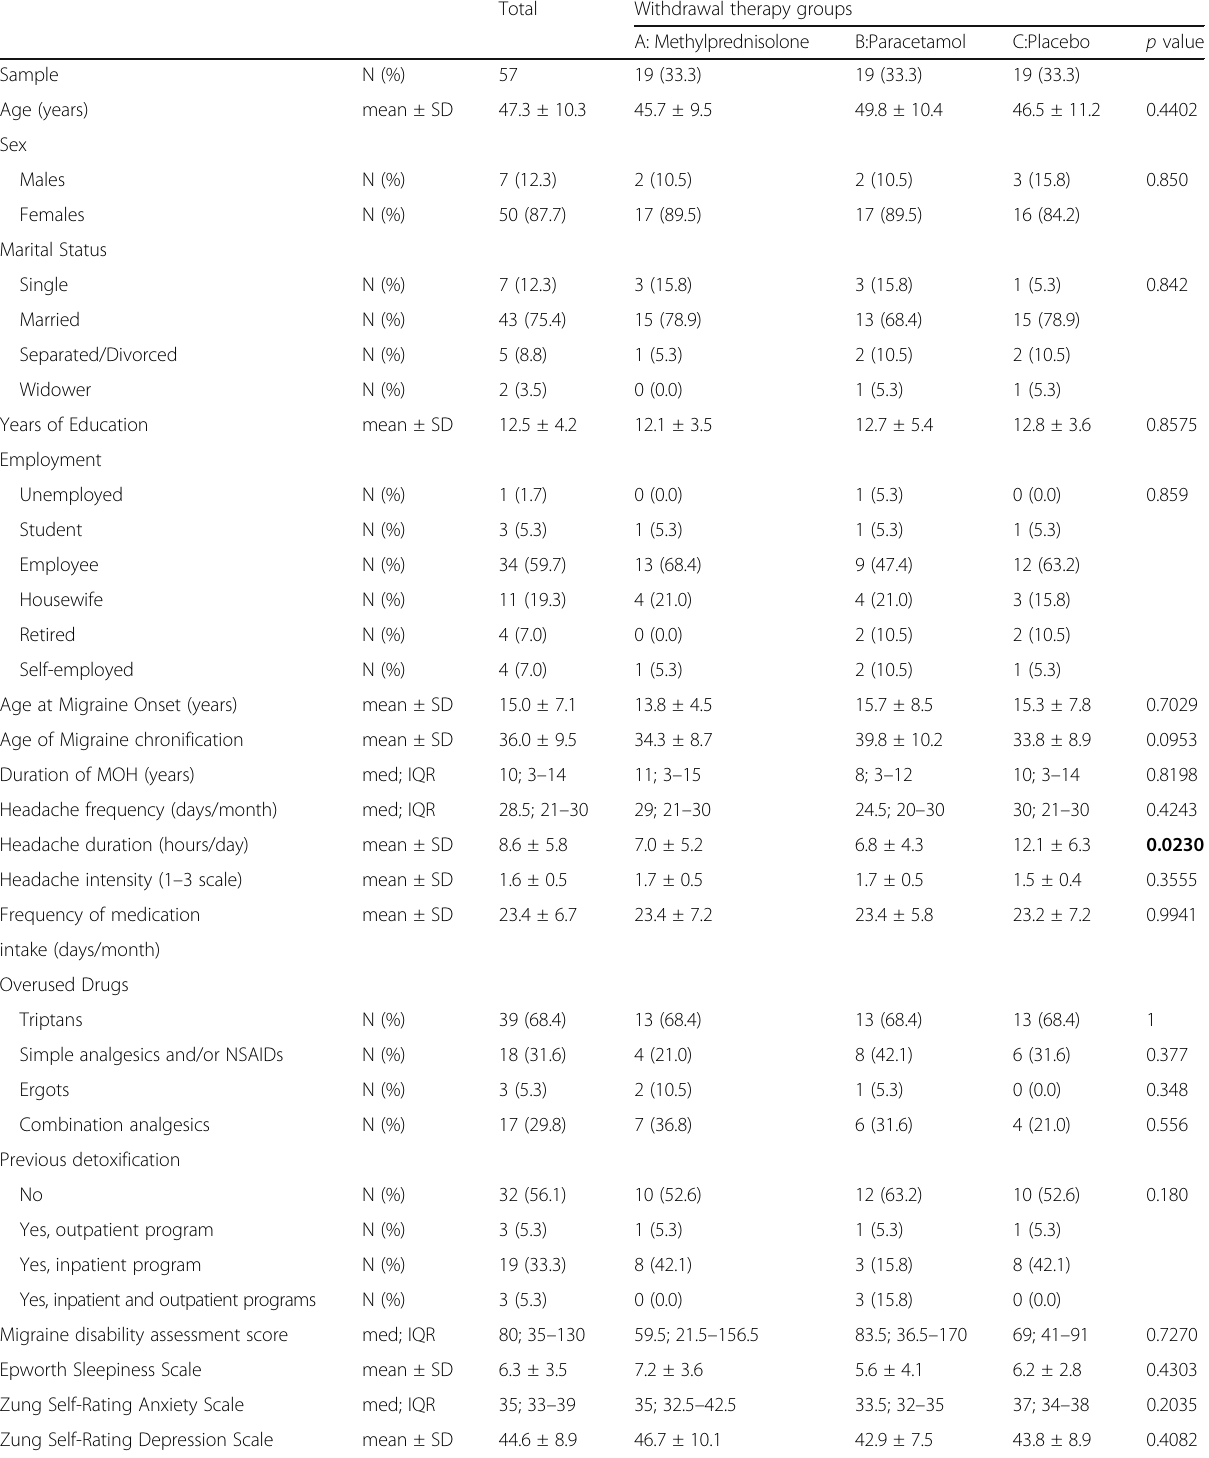
Table 1 Demographic and baseline clinical characteristics of the study